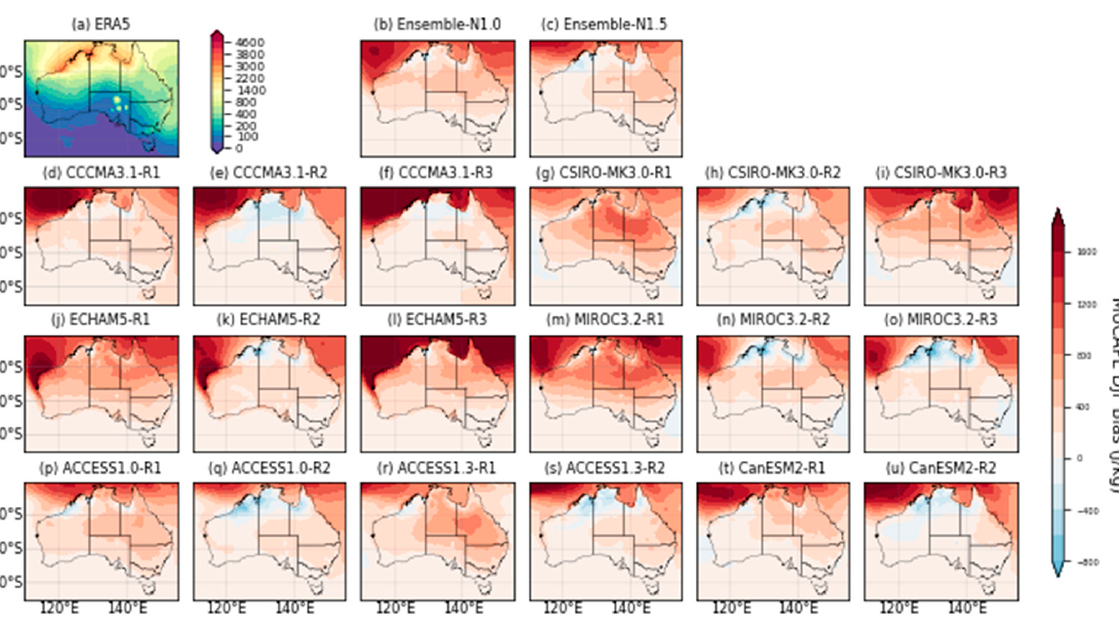
Figure A26. As in Figure A22 except for the NARCliM (d02) domain. References 1. McAneney, J.; Sandercock, B.; Crompton, R.; Morlock, T.; Musulin, R.; Pielki, R.; Gissing, A. Normalised insurance losses from Australian natural disasters: 1966–2017. Environ. Hazards 2019 , 18 , 414–433. 2. Power, S.; Callaghan, J. Variability in severe coastal flooding, associated storms, and death tolls in southeastern Australia since the mid–nineteenth century. J. Appl. Meteorol. Climatol. 2016 , 55 , 1139–1149. 3. Walsh, K.; White, C.J.; McInnes, K.; Holmes, J.; Schuster, S.; Richter, H.; Evans, J.P.; Di Luca, A.; Warren, R.A. Natural hazards in Australia: Storms and hail. Clim. Chang. 2016 , 139 , 55–67. 4. Groenemeijer, P.; Pú č ik, T.; Holzer, A.M.; Antonescu, B.; Riemann-Campe, K.; Schultz, D.M.; Kühne, T.; Feuerstein, B.; Brooks, H.E.; Doswell, C.A., III; et al. Severe convective storms in Europe. Bull. Am. Meteorol. Soc. 2017 , 98 , 2641–2651. 5. Dowdy, A.; Soderholm, J.; Brook, J.; Brown, A.; McGowan, H. Quantifying hail and lightning risk factors using long-term ob- servations around Australia. J. Geophys. Res. Atmos. 2020 , 125 , 2020JD033101. https://doi.org/10.1029/2020JD033101. 6. Taszarek, M.; Allen, J.T.; Groenemeijer, P.; Edward, R.; Brooks, H.E.; Chmielewski, V.; Enno, S.-E. Severe convective storms across Europe and the United States. Part I: Climatology of lightning, large hail, severe wind, and tornadoes. J. Clim. 2020 , 33 , 10239–10260. 7. Taszarek, M.; Allen, J.T.; Marchio, M.; Brooks, H.E. Global climatology and trends in convective environments from ERA5 and rawinsonde data. Npj Clim. Atmos. Sci. 2021 , 4 , 35. https://doi.org/10.1038/s41612-021-00190-x.